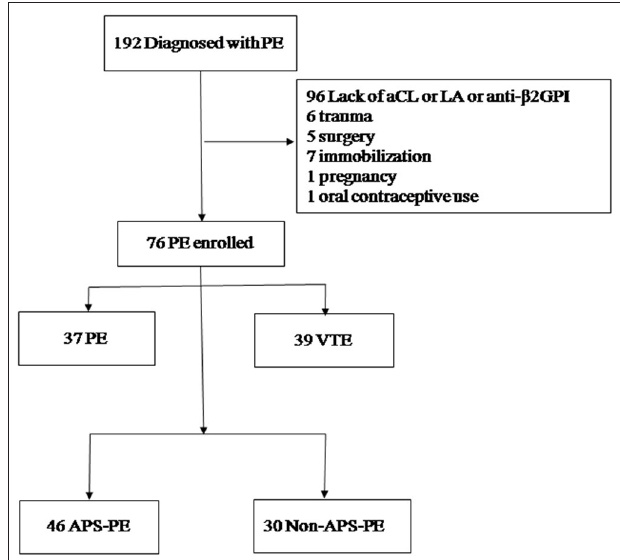
FIGURE 1 | Patient selection flowchart. PE, pulmonary embolism; VTE, venous thromboembolism; DVT, deep vein thrombosis; aCL, anti-cardiolipin antibodies; LA, lupus anti-coagulant; a β 2GPI, anti- β 2-glycoprotein I, APS, antiphospholipid